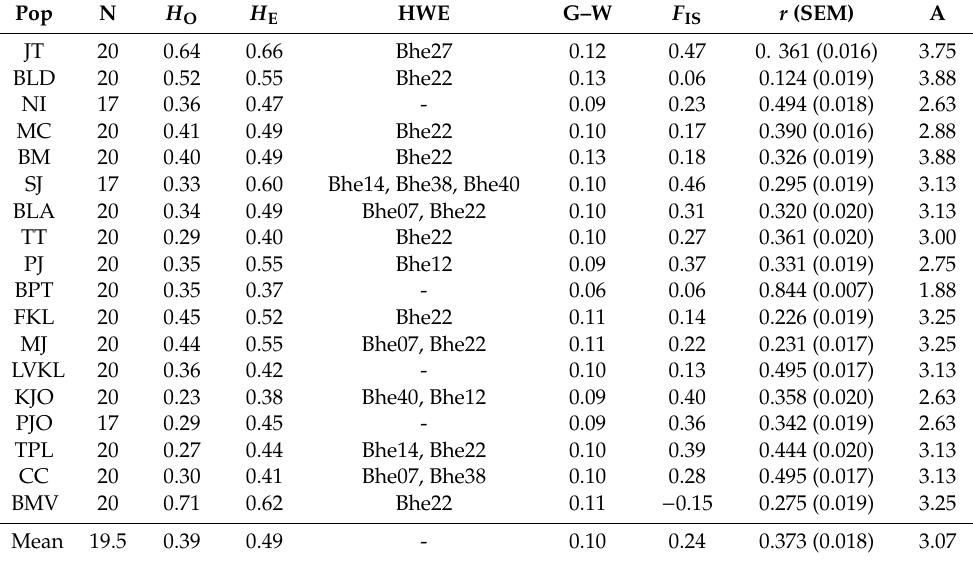
Table 3. Summary statistics of 351 C. hemipterus samples from 18 populations genotyped at eight microsatellite